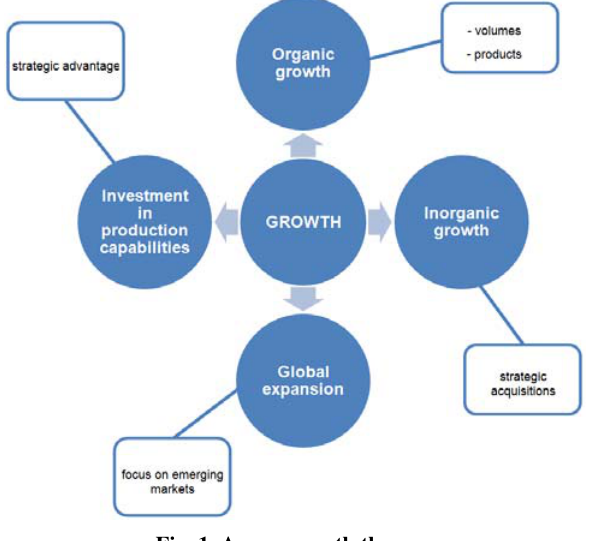
Fig. 1. Aspen growth